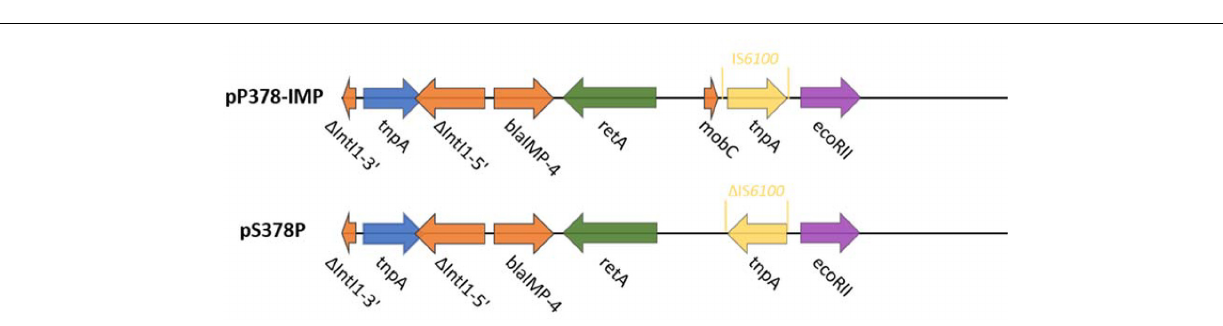
FIGURE 2 | Plasmid accessory resistance regions. The genetic environment comparison of bla IMP − 4 between pP378-IMP and pS378P. Genes are denoted by arrows and colored based on gene function